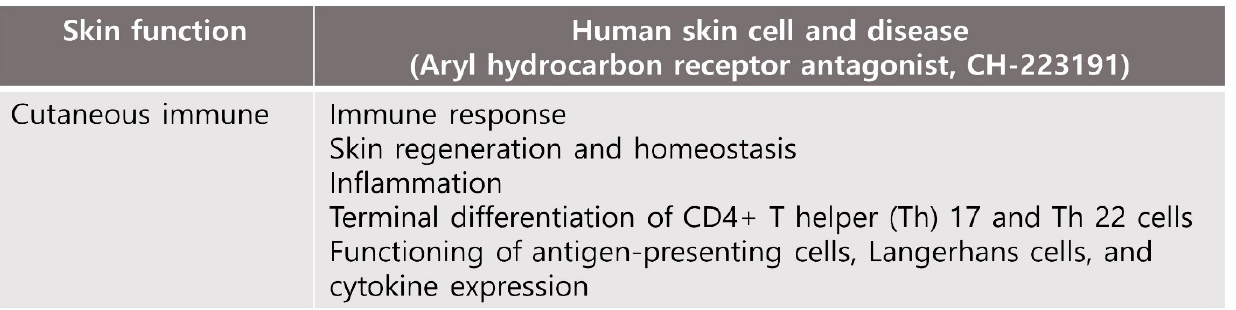
Figure 3. Effects of human skin cell and disease by AhR antagonist exposure and downregulation of AhR. AhR is involved in many skin functions including those of the skin immune network as well as in cell homeosis.